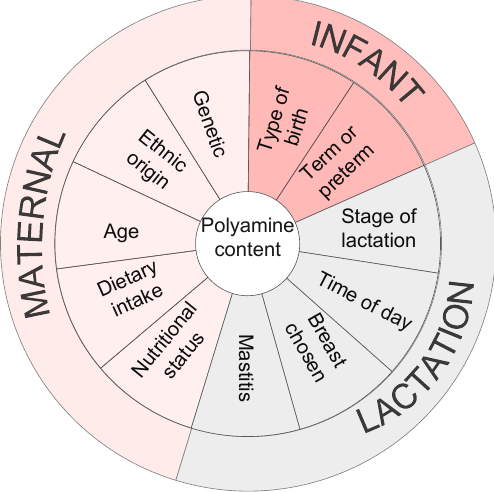
Figure 1. Factors influencing the polyamine content of human milk